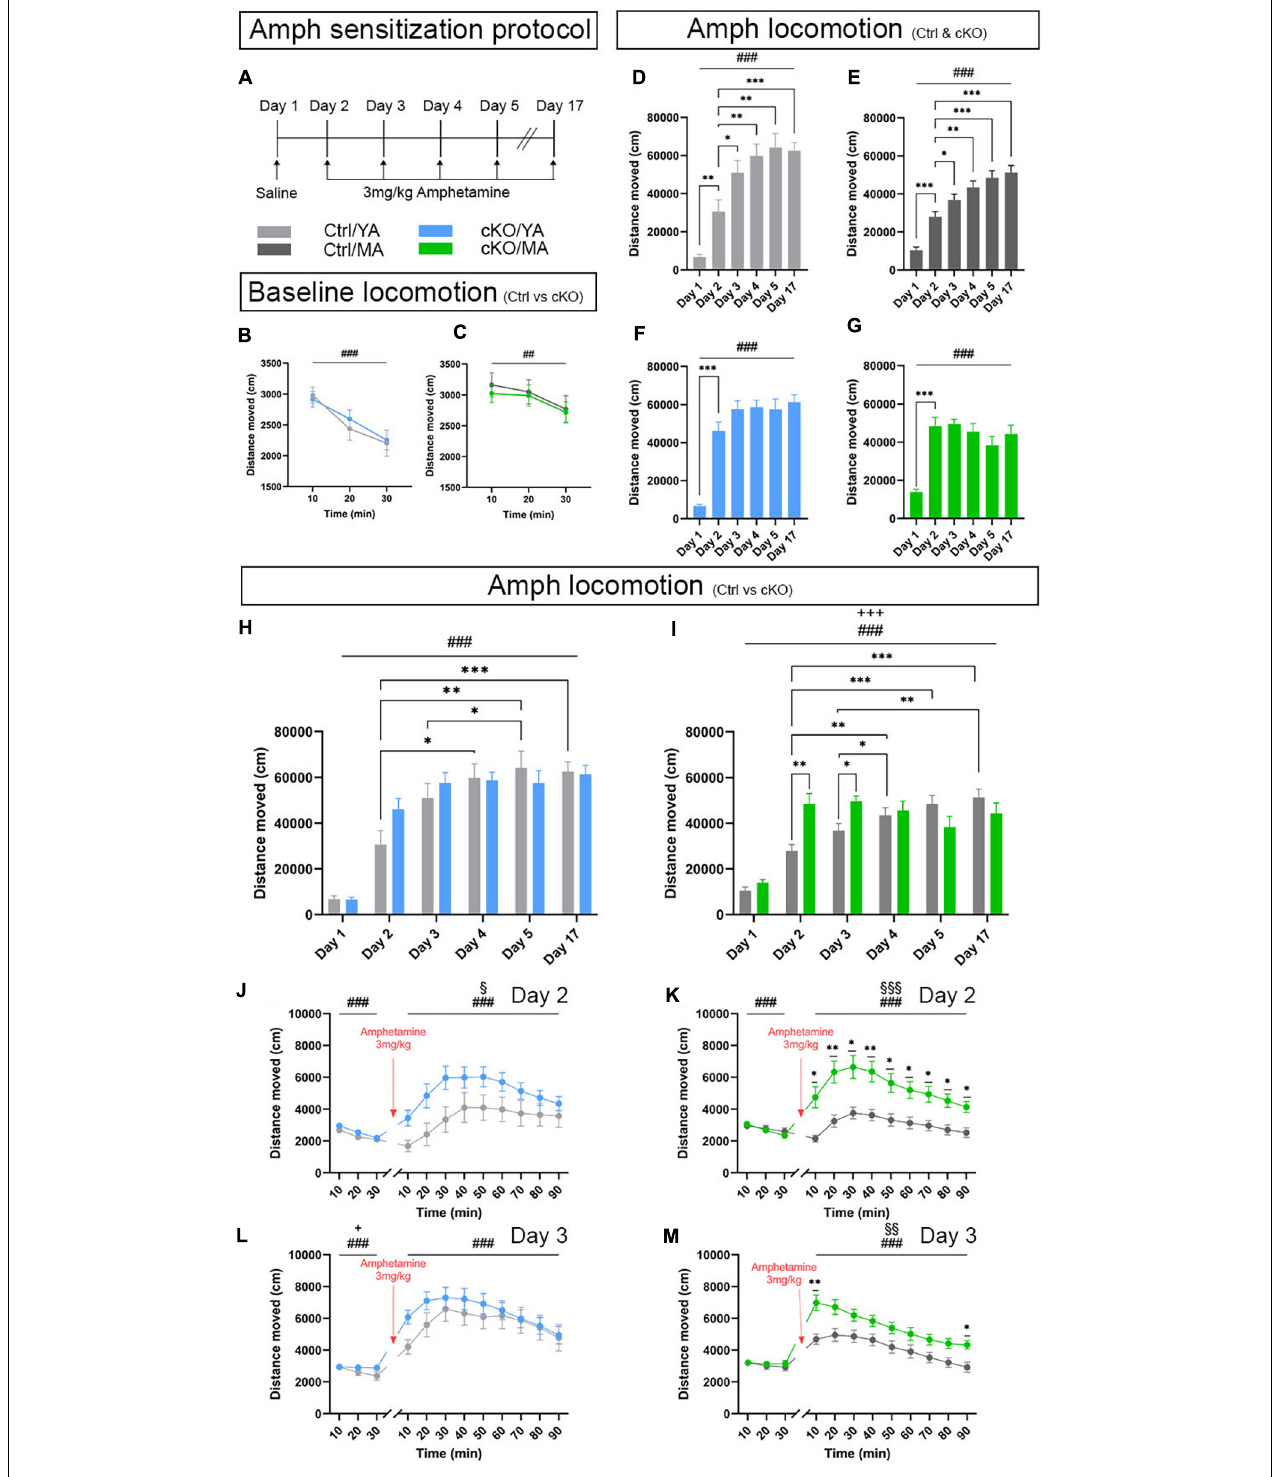
FIGURE 8 | An amphetamine sensitization paradigm identifies altered locomotor response displayed by TrpV1 Cre + / wt ;Vmat2 flox / flox cKO mice. Analysis and comparison of age-matched TrpV1 Cre − / wt ;Vmat2 flox / flox control (Ctrl) and TrpV1 Cre + / wt ;Vmat2 flox / flox conditional knockout (cKO) mice at young adult (YA; 8 weeks old) and mature adult (MA; 18 weeks old) age. (A) Amphetamine sensitization protocol. (B,C) Locomotor activity during 30 min that preceded saline injection. (B) Ctrl/YA ( N = 14) and cKO/YA ( N = 22). Data expressed as mean ± SEM (### p < 0.001, time effect). (C) Ctrl/MA ( N = 18) and cKO/MA ( N = 18). Data